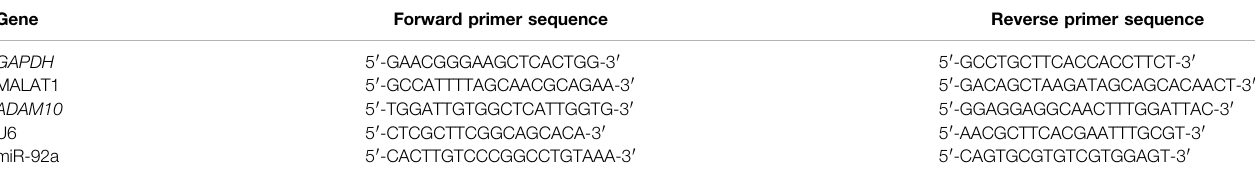
TABLE 1 | Primer sequences used for